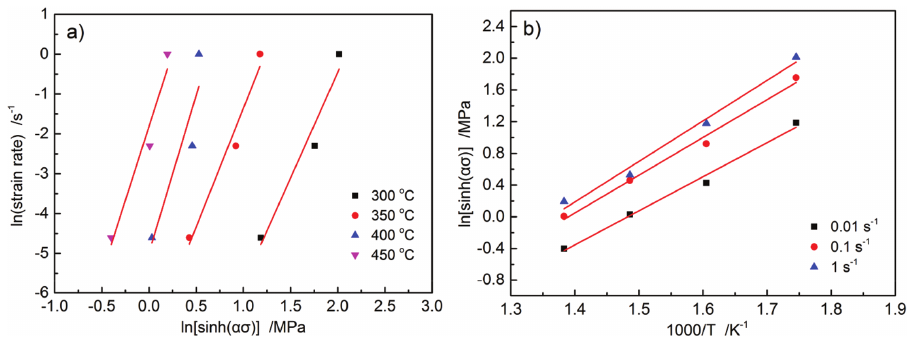
Figure 5: Relationships between ln[sinh( ασ )] and (a) ln _ ε and (b) 1/ T